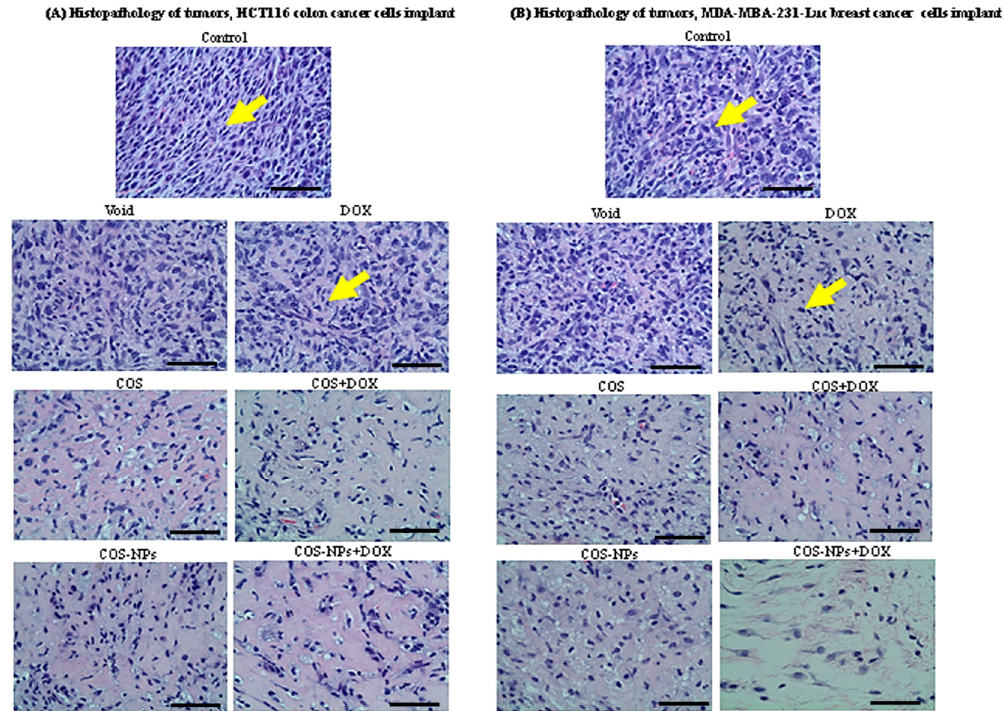
Figure 10. Histopathological assessment of tumor masses sections in ( A ) HCT116 colon cancer cells implant and ( B ) MDA- MB-231-Luc breast cancer cells implant treated with costunolide (COS), doxorubicin (DOX), costunolide + doxorubicin (COS + DOX), costunolide-nanoparticles (COS-NPs), and costunolide-nanoparticles + doxorubicin (COS-NPs + DOX). Yellow arrows refer to viable cancer cells. Scale bar shows magnification 40 ×